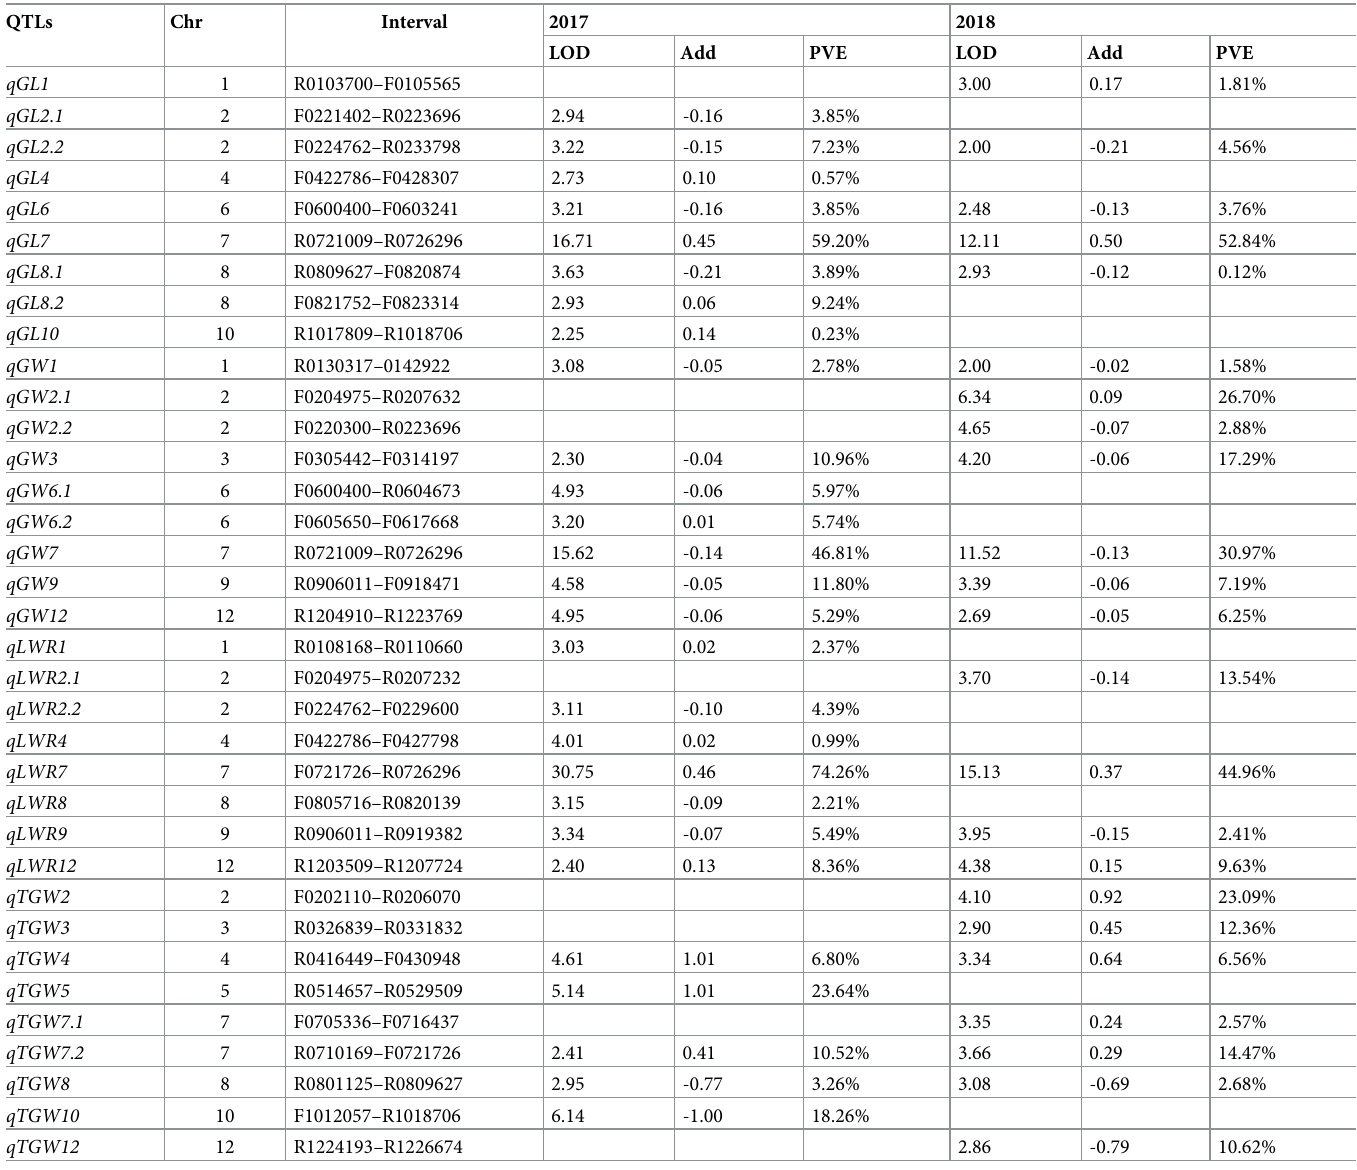
Table 3. Putative QTLs for grain shape traits detected in two